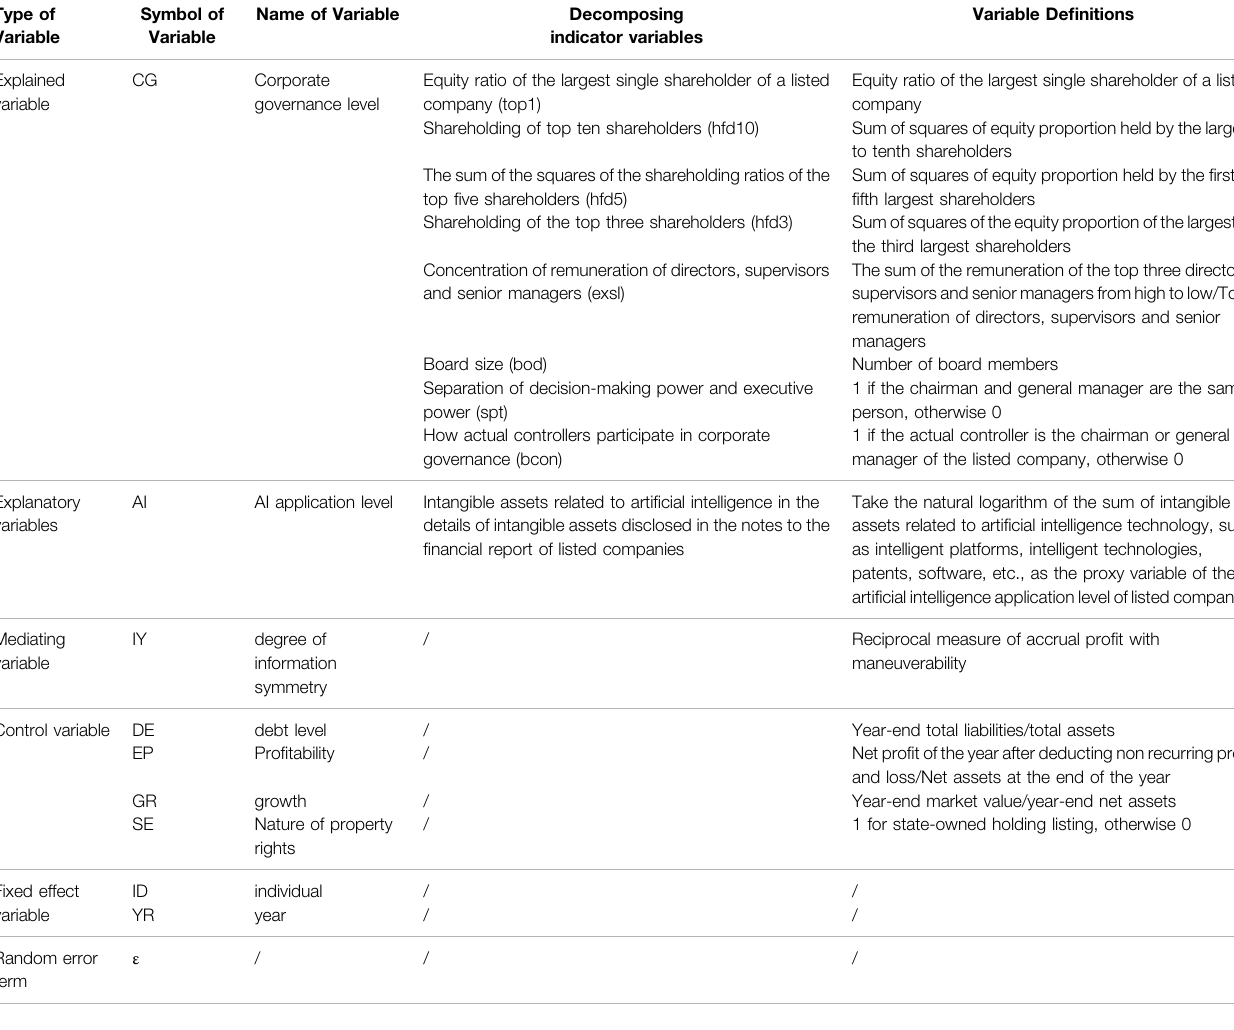
TABLE 1 | De fi nitions of study variables.